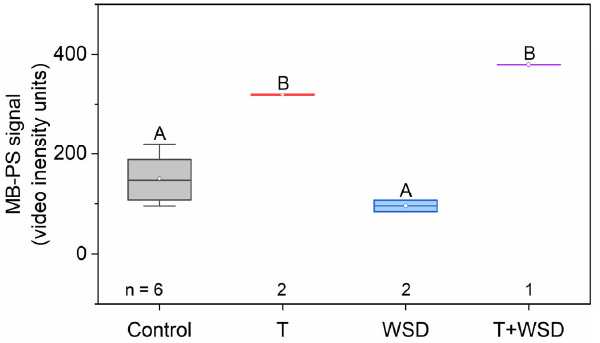
Figure 1. Treatment with testosterone (increases phosphatidylserine-shelled microbubble (MB-PS) signal). MB-PS signal was measured once during pregnancy at gestational day (GD) 135 in female macaques that were fed a control or an obesogenic, western-style diet (WSD) in the presence and absence of subcutaneous testosterone (T) implants. Letters above box plots indicate a significant main effect of T ( t = 5.91, p < 0.001).